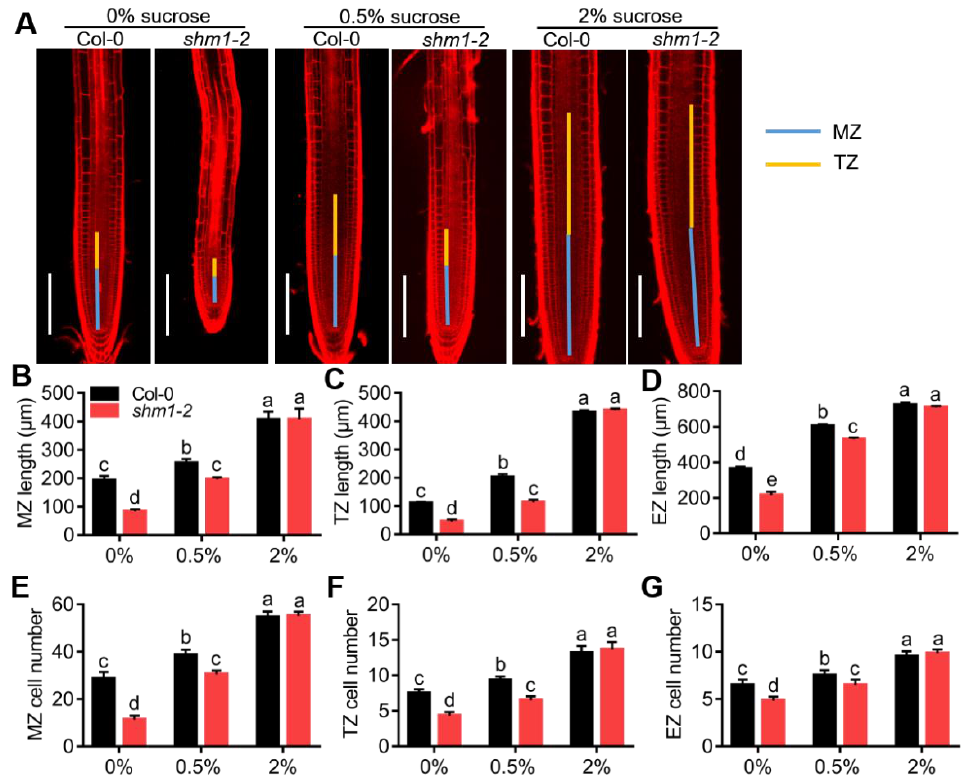
Figure 4. Root-meristem activity in the shm1-2 mutant was reduced at low-sucrose conditions. ( A ) The root-meristem and transition-zone size of Col-0 and shm1-2 at 0%, 0.5%, and 2% sucrose conditions. ( B – D ) The MZ, TZ, and EZ lengths of Col-0 and shm1-2 at 0%, 0.5%, 2% sucrose conditions. ( E – G ) The corresponding cell number in the MZ, TZ and EZ at 0%, 0.5%, and 2% sucrose conditions. MZ, meristem zone, TZ, transition zone, EZ, elongation zone. Data presented were means ± SD, n = 3 experiments, each with 10 roots per experiment. Bars = 200 μm. Different letters above error bars indicated significant difference at p < 0.05, using two-way ANOVA with Tukey’s test.